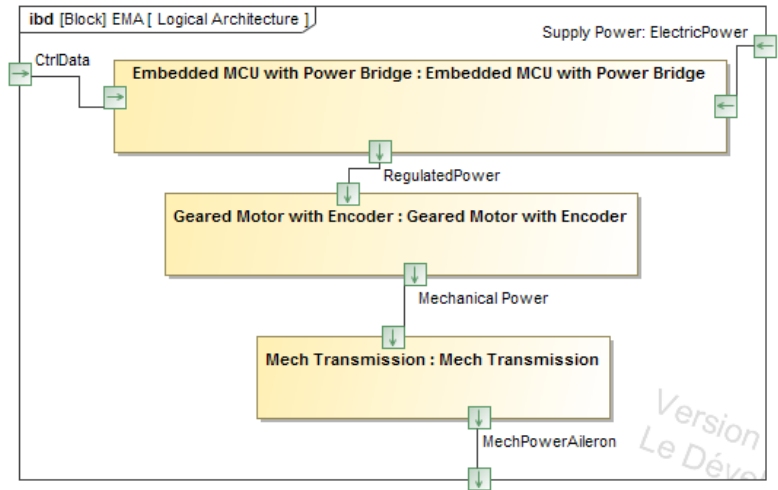
Figure 5. Initial structure of the